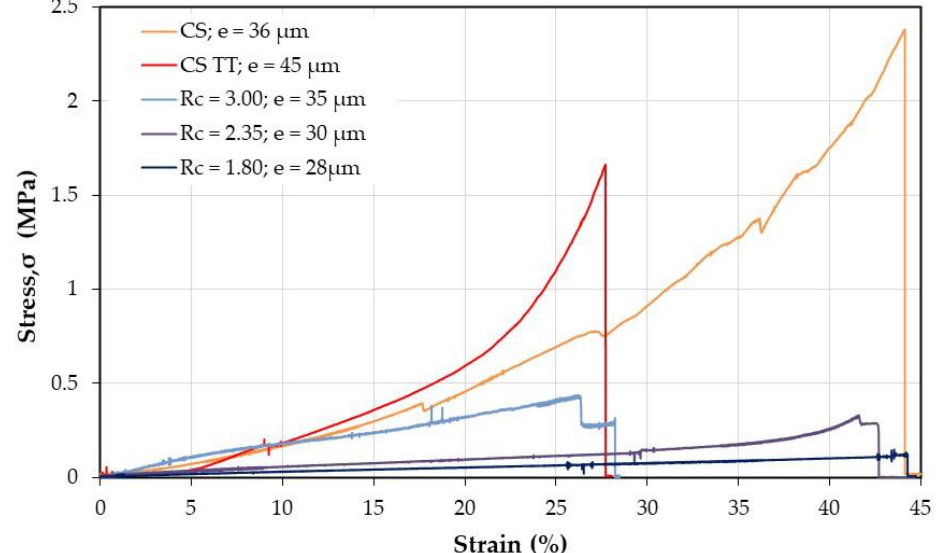
Figure 11. Effect of thermal treatment on mechanical response of chitosan and PEC films in the wet state after stabilization in PBS at pH = 7.4.